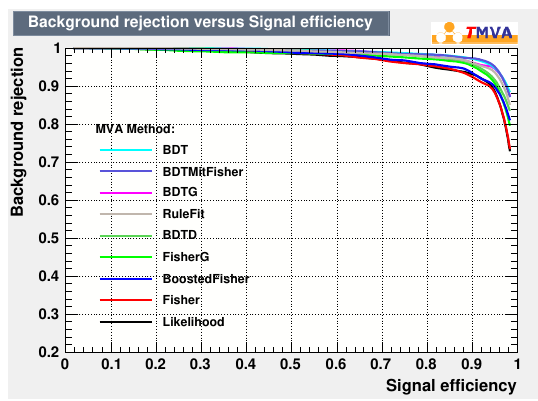
Figure 9. Most performant methods in terms of correct jet assignment for t (cid:22) tA events with m A = 40 GeV. We found that typically BDT or BDTG are the best for all (cid:30) boson masses.